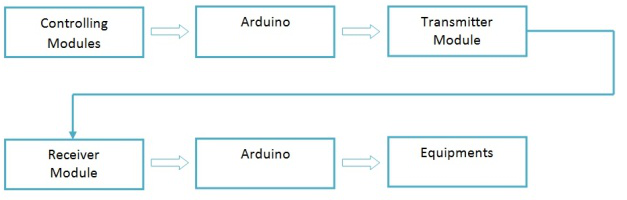
Fig. 1. Overview of the